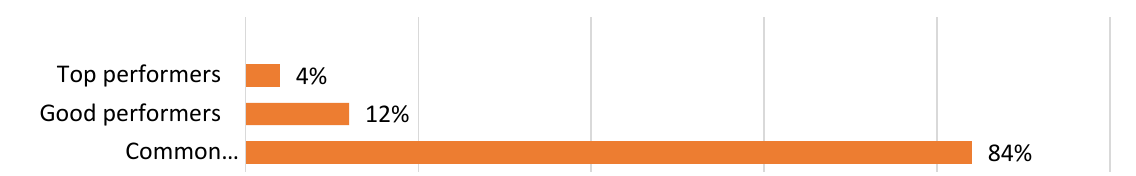
Source: The data